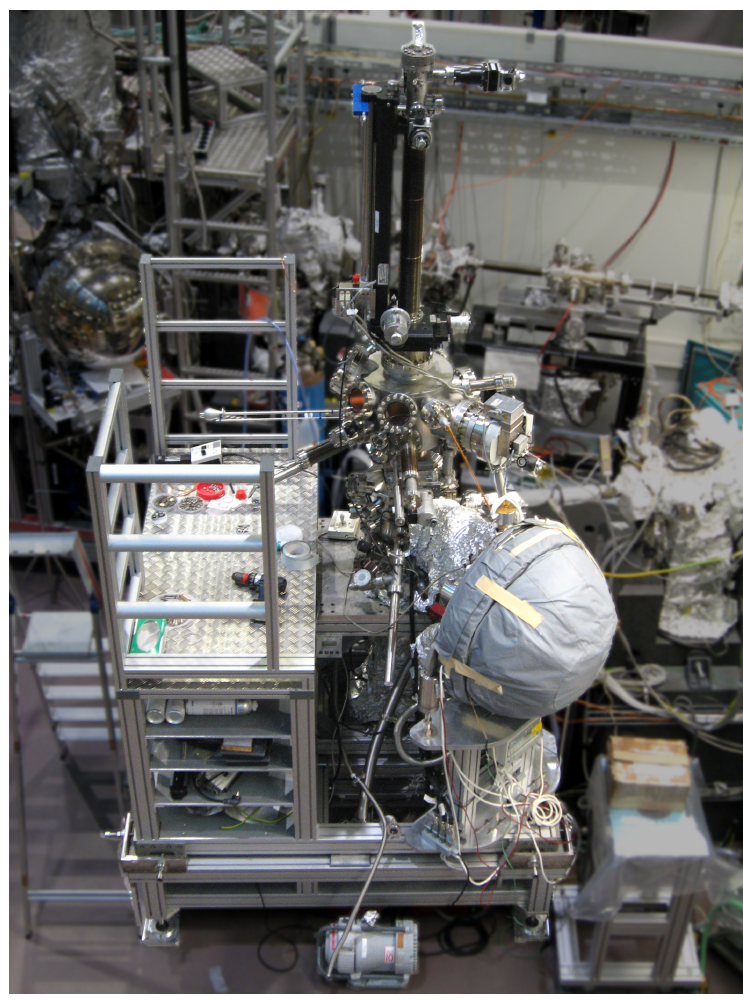
Figure 1: Aerial view of ARPES 12 endstation in experimental hall of BESSY-II.